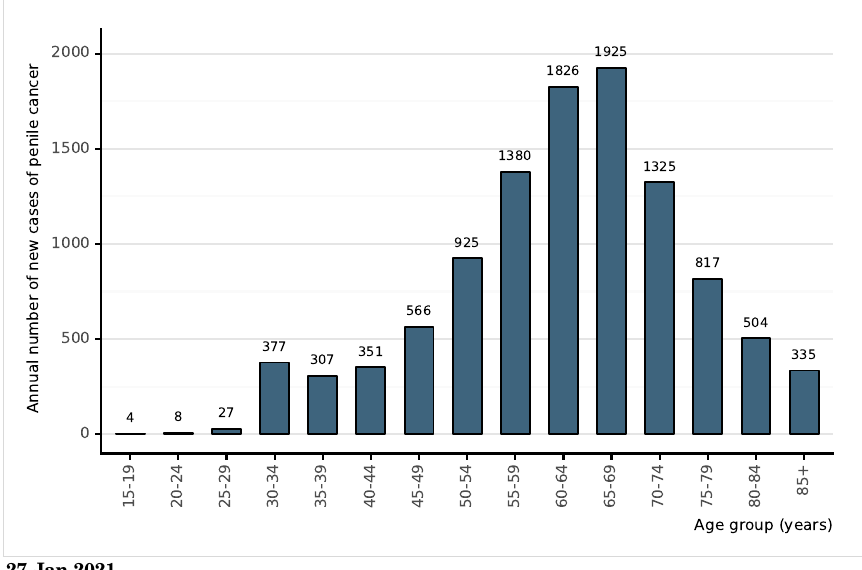
Figure 32: Annual number of new cases of penile cancer in India (estimates for